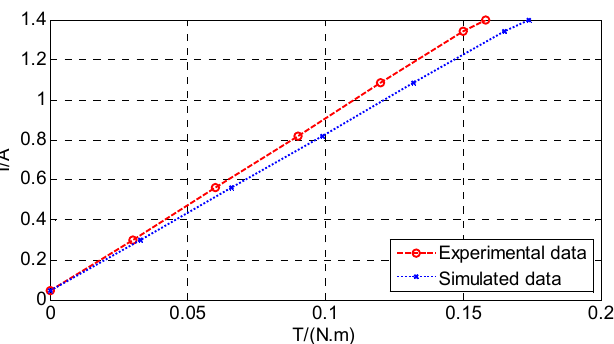
Figure 20. Comparison between calculated and experimental data.